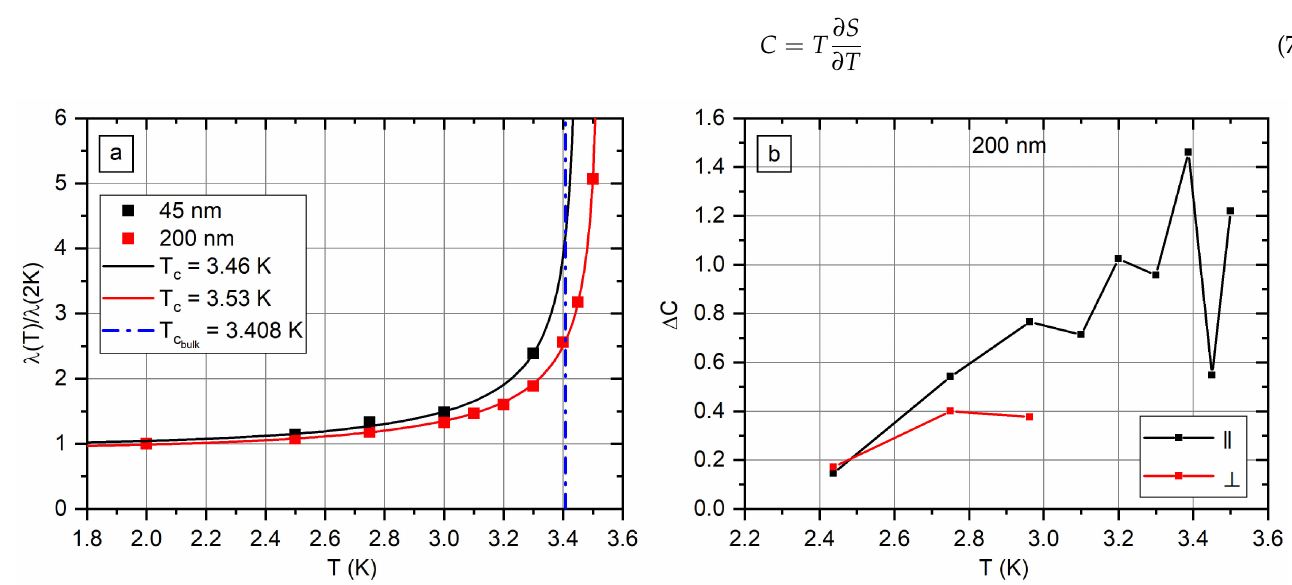
Figure 9. Magnetic field penetration depth as a function of temperature ( a ). The difference in heat capacities ∆ C of the normal and the superconducting states as a function of temperature ( b